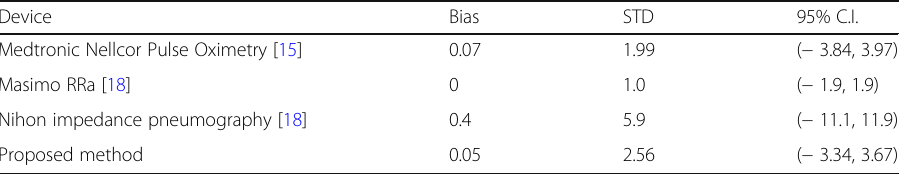
Table 3 Table comparing the performance of other respiratory rate devices reported in literature and the proposed method of respiratory rate